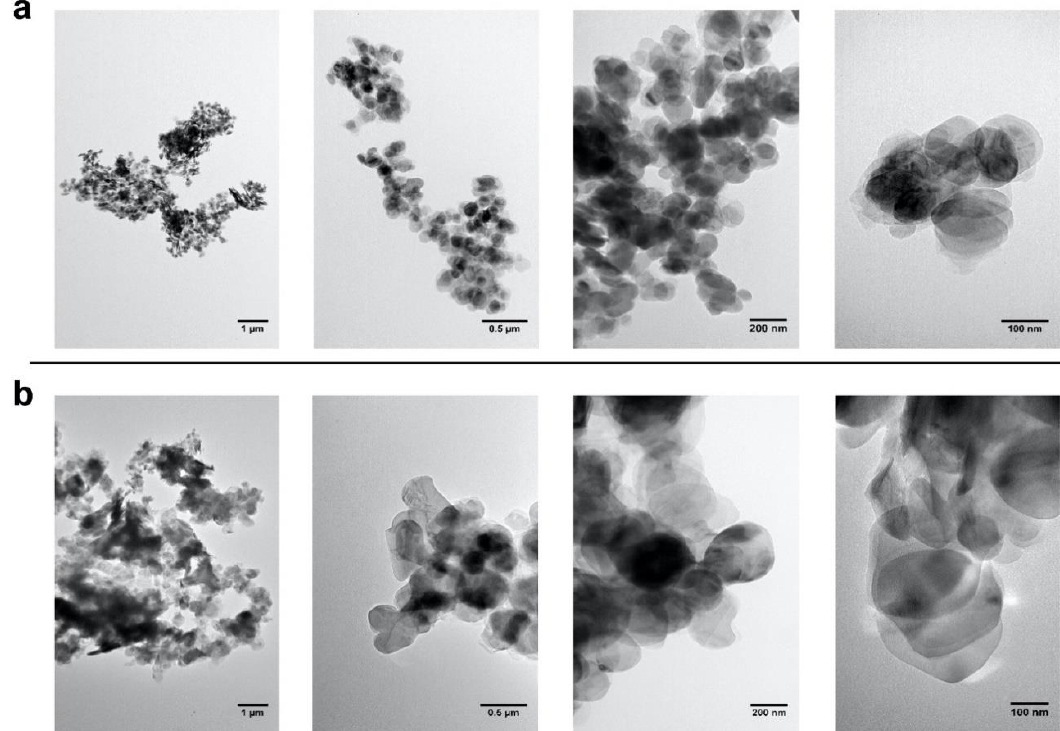
Figure 3. TEM images of BN nanopowder ( a ) and BN nanoplatelets ( b ). BN dispersions with a concentration of 20 mg/L were deposited by drop casting on carbon-coated copper grids.